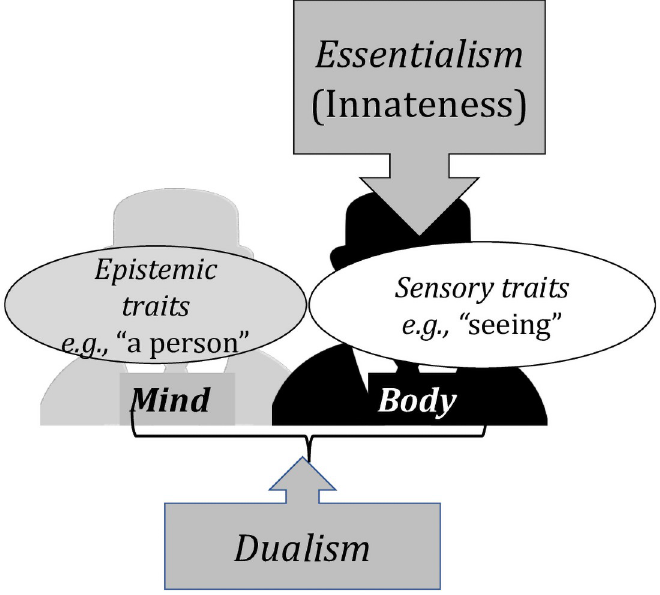
Fig 1. The role of Dualism and Essentialism in reasoning about typical psychological